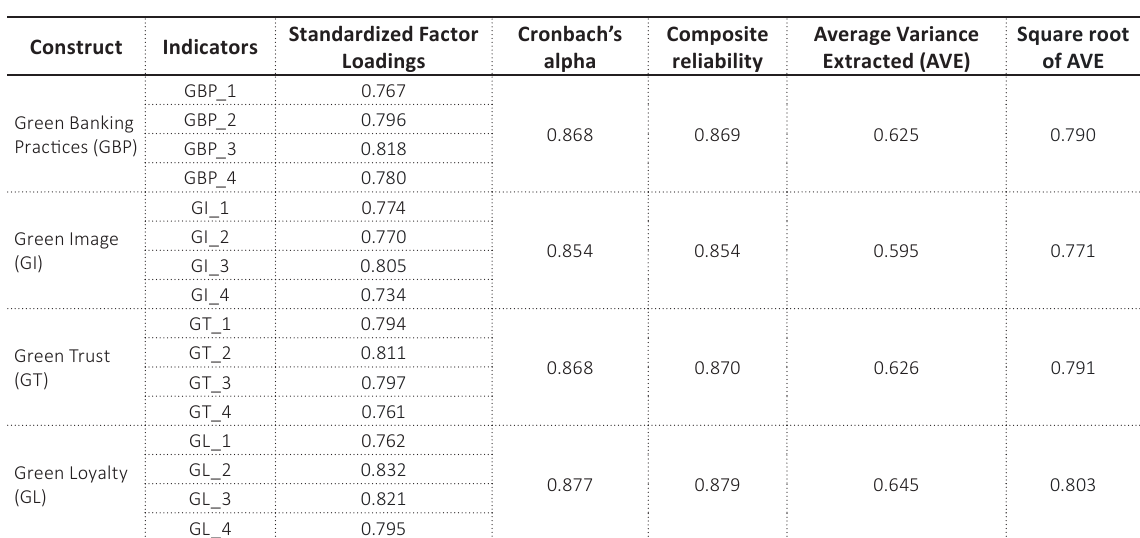
Table 3. Convergent